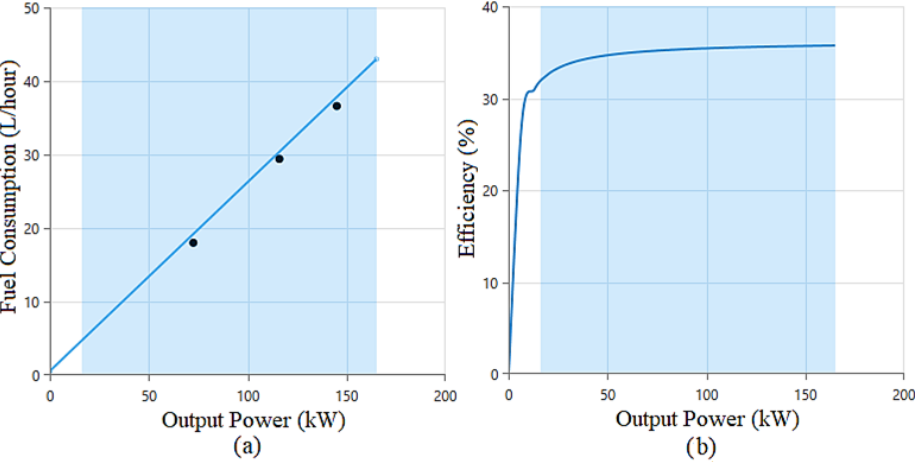
Figure 4. Modeling of diesel generator in Homer Pro, ( a ) relationship between power and fuel consumption, ( b ) efficiency